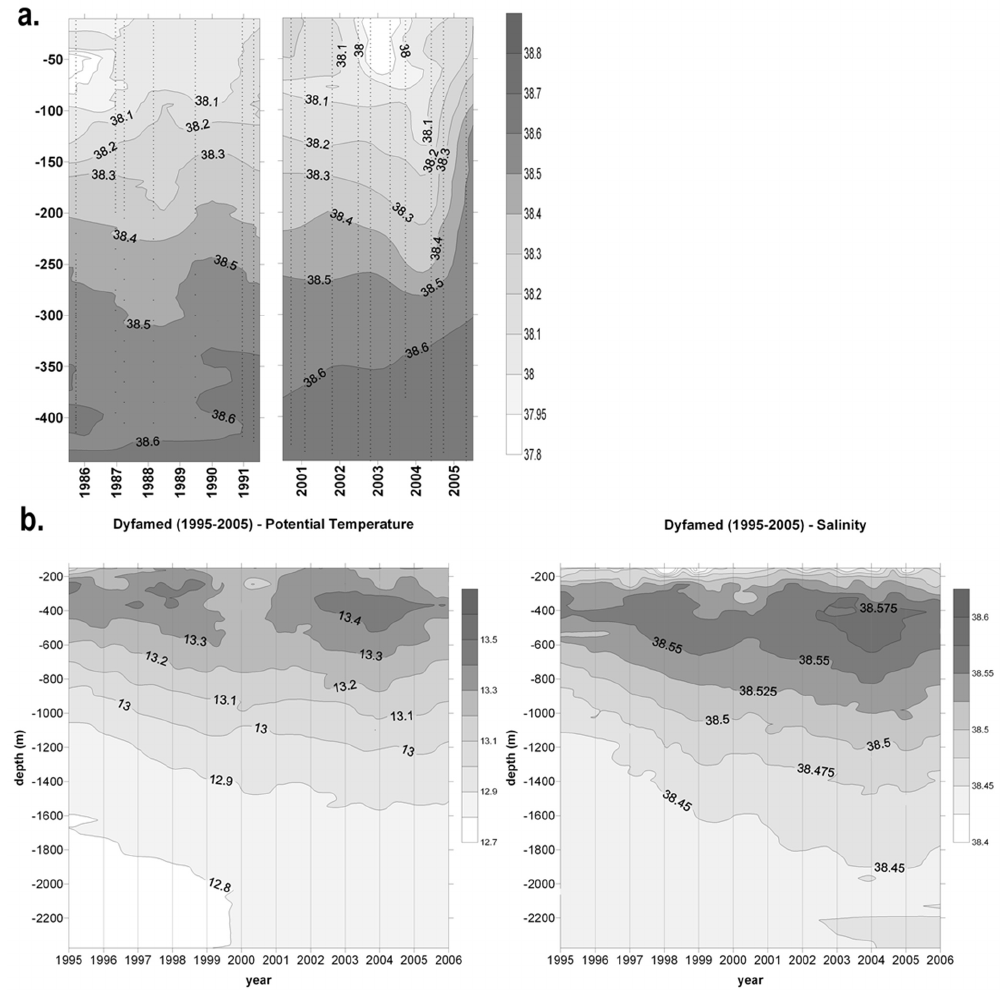
Fig. 8. (a) Temporal evolution of salinity in the Corsica Channel; (b) temporal evolution of potential temperature and salinity at the DY- FAMED site showing the propagation of the EMT towards the